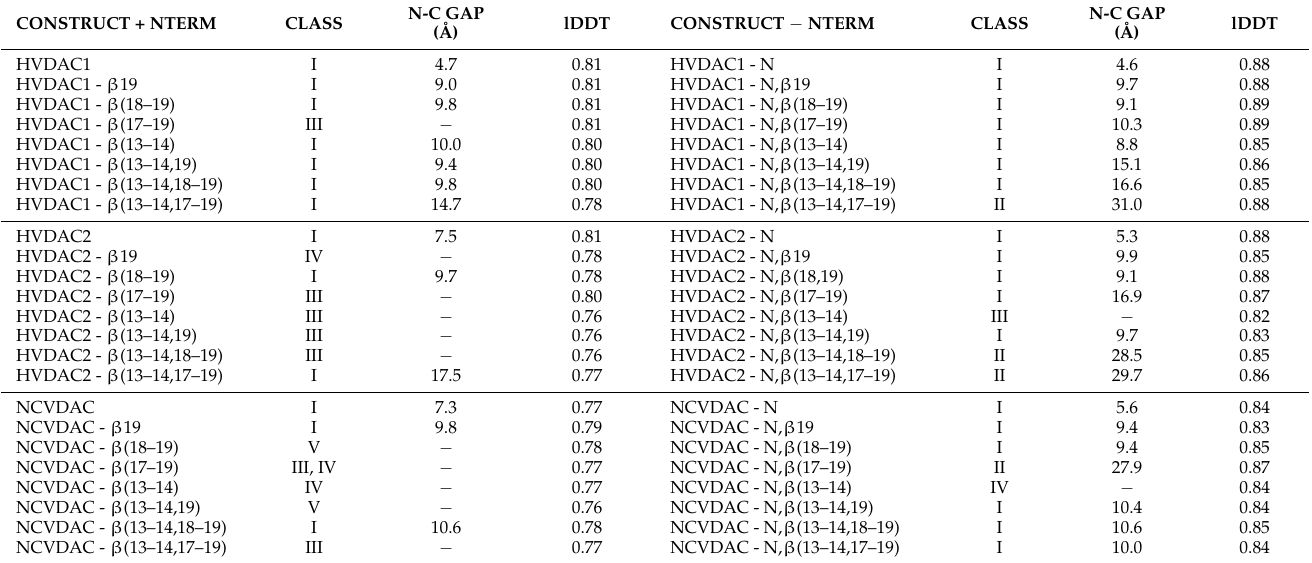
Table 1. Folding predictions for VDAC monomer constructs 1